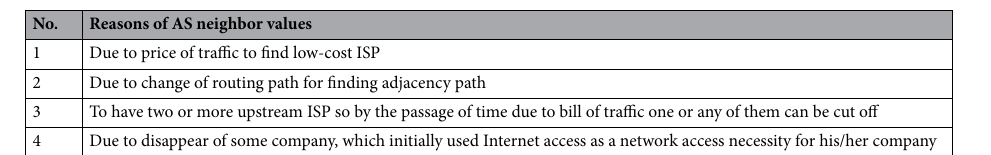
Table 2. Reasons of AS neighbor